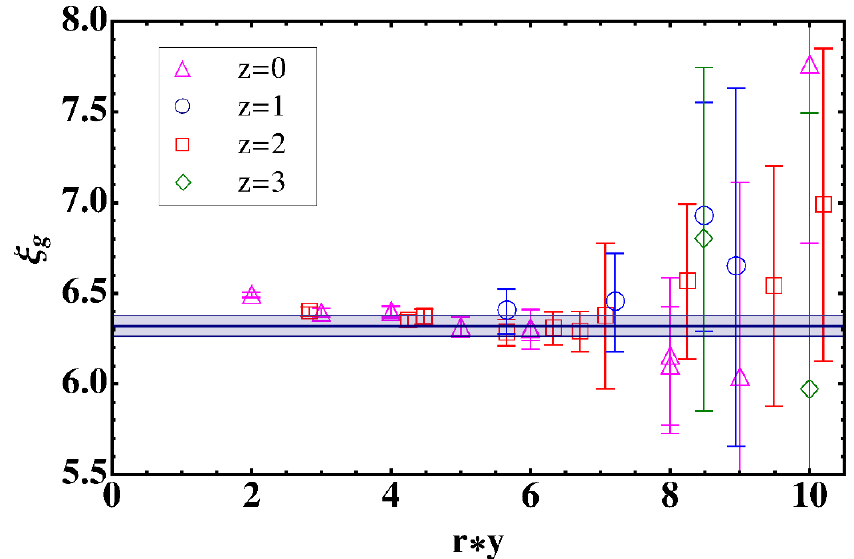
Figure 2 . Lattice artefacts due to nonplanar Wilson loops. Di(cid:11)erent colored points denote the (cid:24) g obtained by using eq. (3.10) with z = 0 ; (cid:1) (cid:1) (cid:1) ; 3 for a given r (cid:3) y , while the blue band denotes the extracted value of (cid:24) g . The details are found in the main